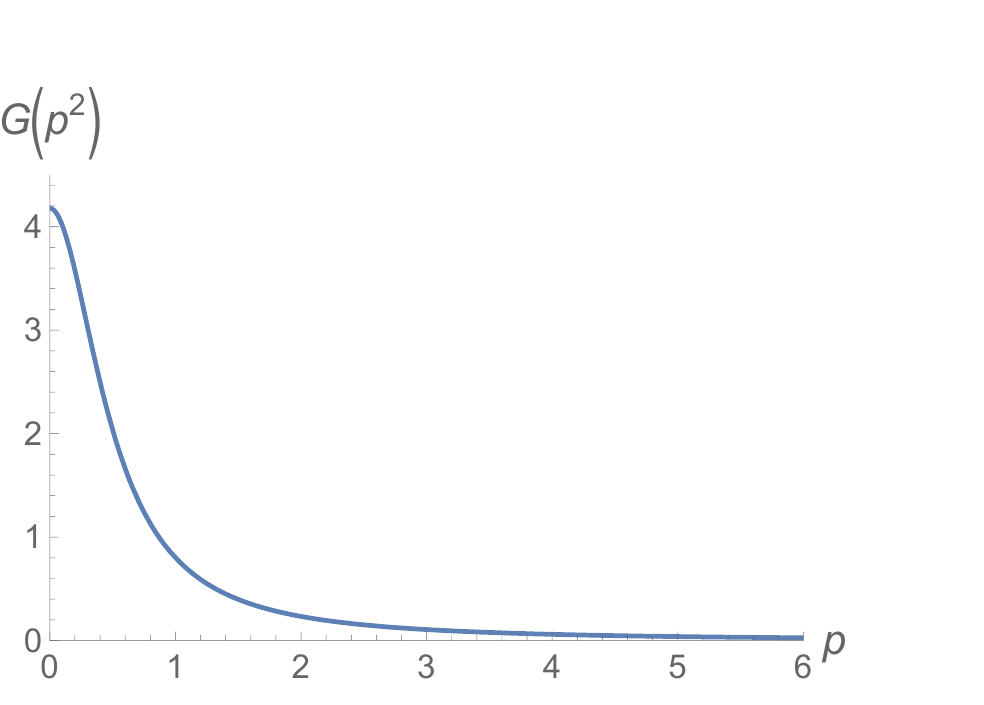
Figure 2 . Resummed Higgs propagator, with all quantities given in units of appropriate powers of the energy scale (cid:22) , for the parameter values e = 1, v = 1 (cid:22) , (cid:21) = 1